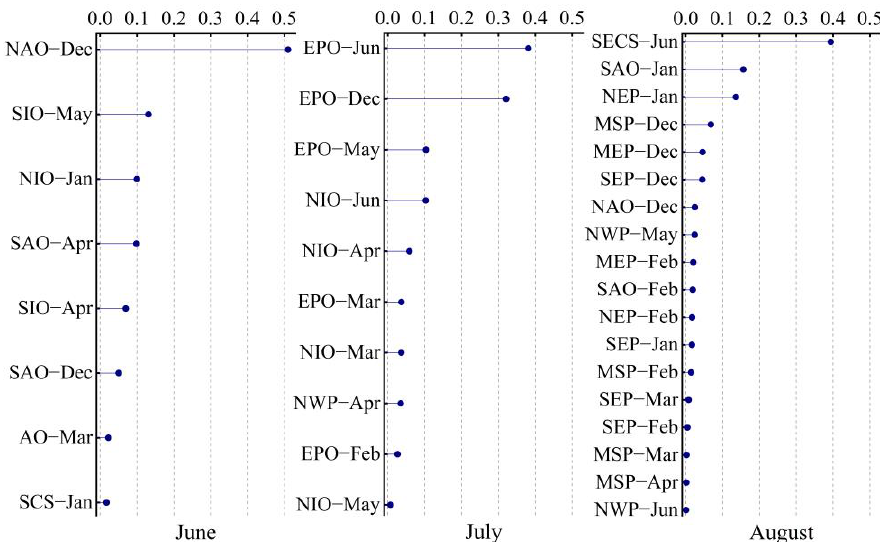
Figure 5. FI of RF in June, July, and August.